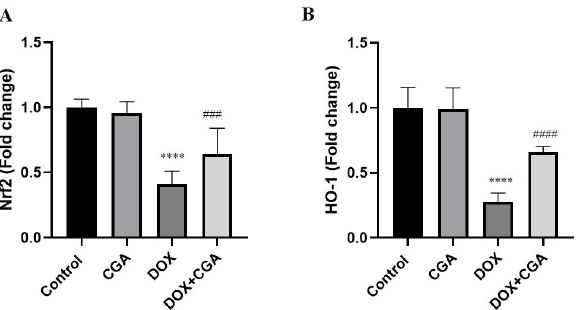
Figure 6. ( A ) Nrf2 and ( B ) HO-1 signaling pathway in cardiac tissue. The expression levels of Nrf2 and HO-1 were elevated with CGA treatment. Data are presented as the means ± SD. **** p < 0.0001 vs. the control group, ### p < 0.001, #### p < 0.0001 vs. the DOX group (n = 7). CGA: Chlorogenic acid (100 mg/kg); DOX: Doxorubicin (15 mg/kg); Nrf2: Nuclear factor erythroid 2–related factor 2; HO-1: Heme Oxygenase 1.